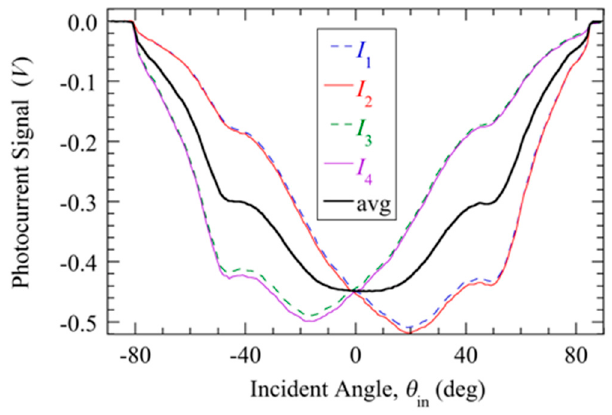
Figure 3. Photocurrent signal from transimpedance amplifier for each cathode current.